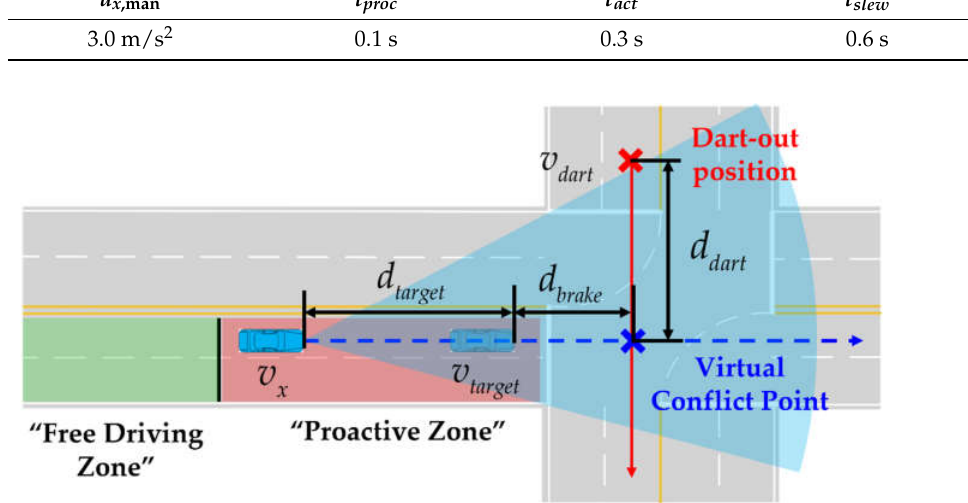
Figure 5. Target state decision for intersection approach motion. Table 1. Parameters for target state decision for approach motion.